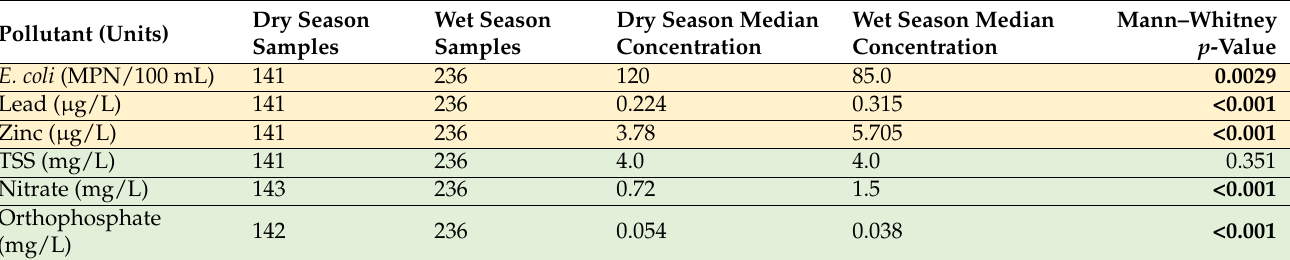
Table 1. Median seasonal concentrations and Mann–Whitney U test p -values for samples originating from 36 eligible stations. Pollutants from anthropogenic sources are shaded yellow, while pollutants from more natural sources are shaded green. Bolded entries signify statistical significance ( p < 0.05).